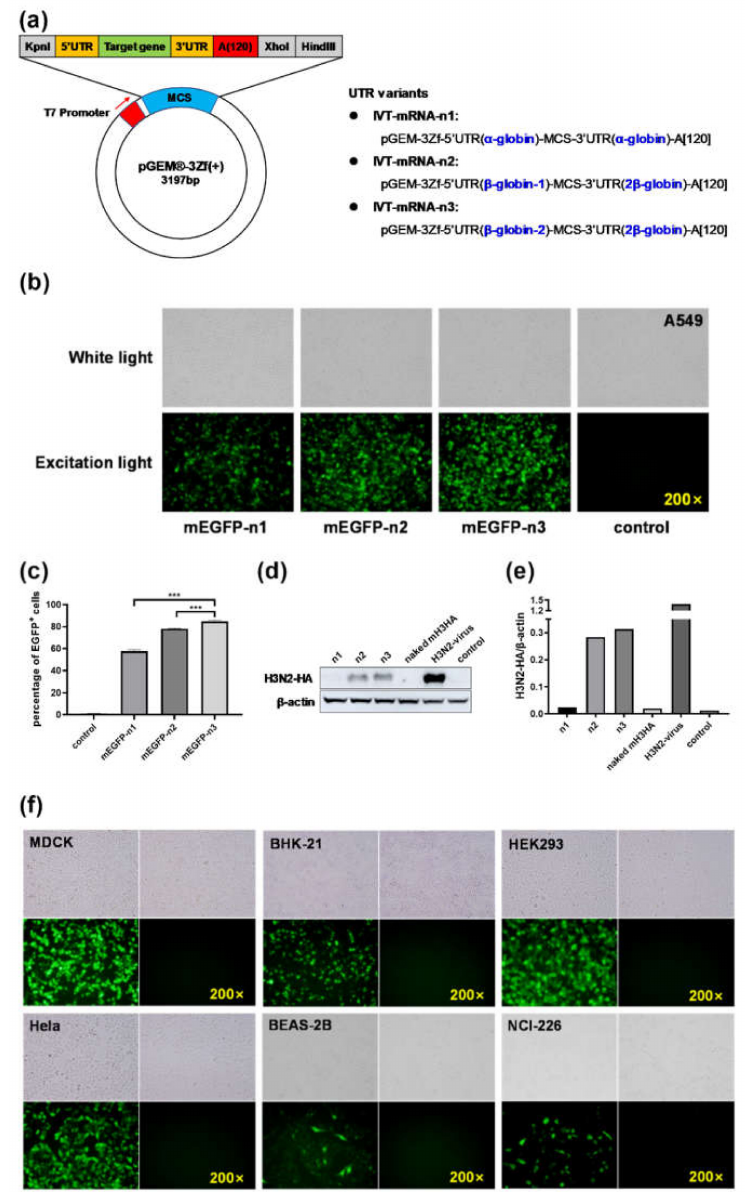
Figure 1. ( a ) Pattern diagram of the three modes of in vitro transcription systems. A549 cells